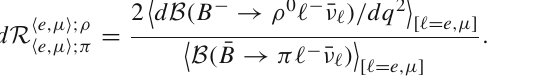
Table 1 Experimental values of B ( ¯ B → ρ(cid:2) − ¯ ν (cid:2) ) in different q 2 intervals [36]. The fourth column gives the isospin averages of the values in the second and third columns